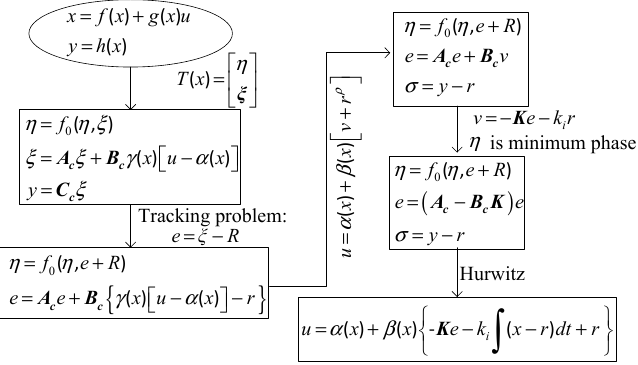
Figure 4. Procedure flowchart for the control scheme design.